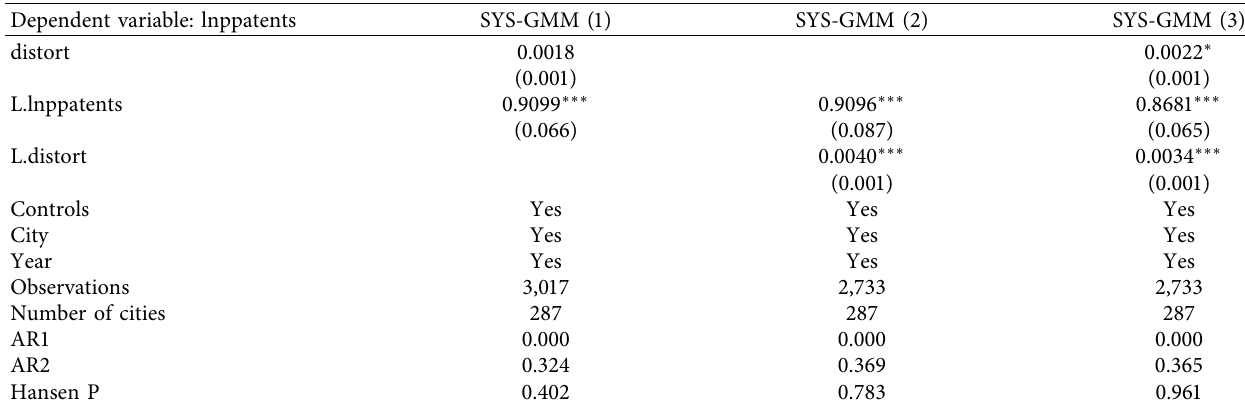
Table 5: Estimate results of system GMM method.